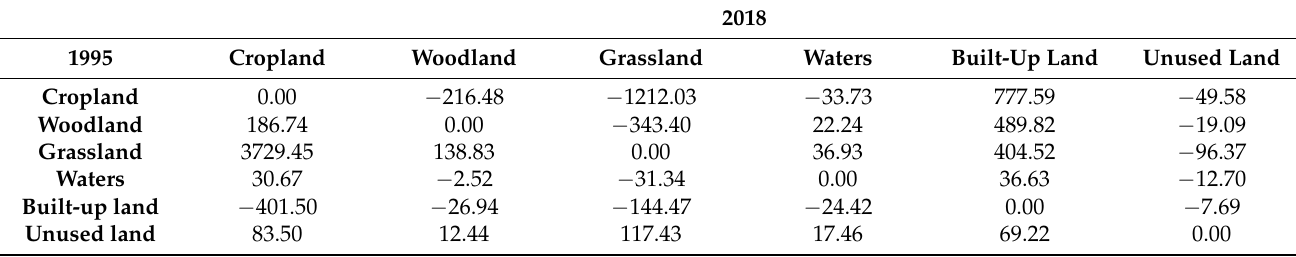
Table 6. Land use social benefit change caused by land use change (hundred million